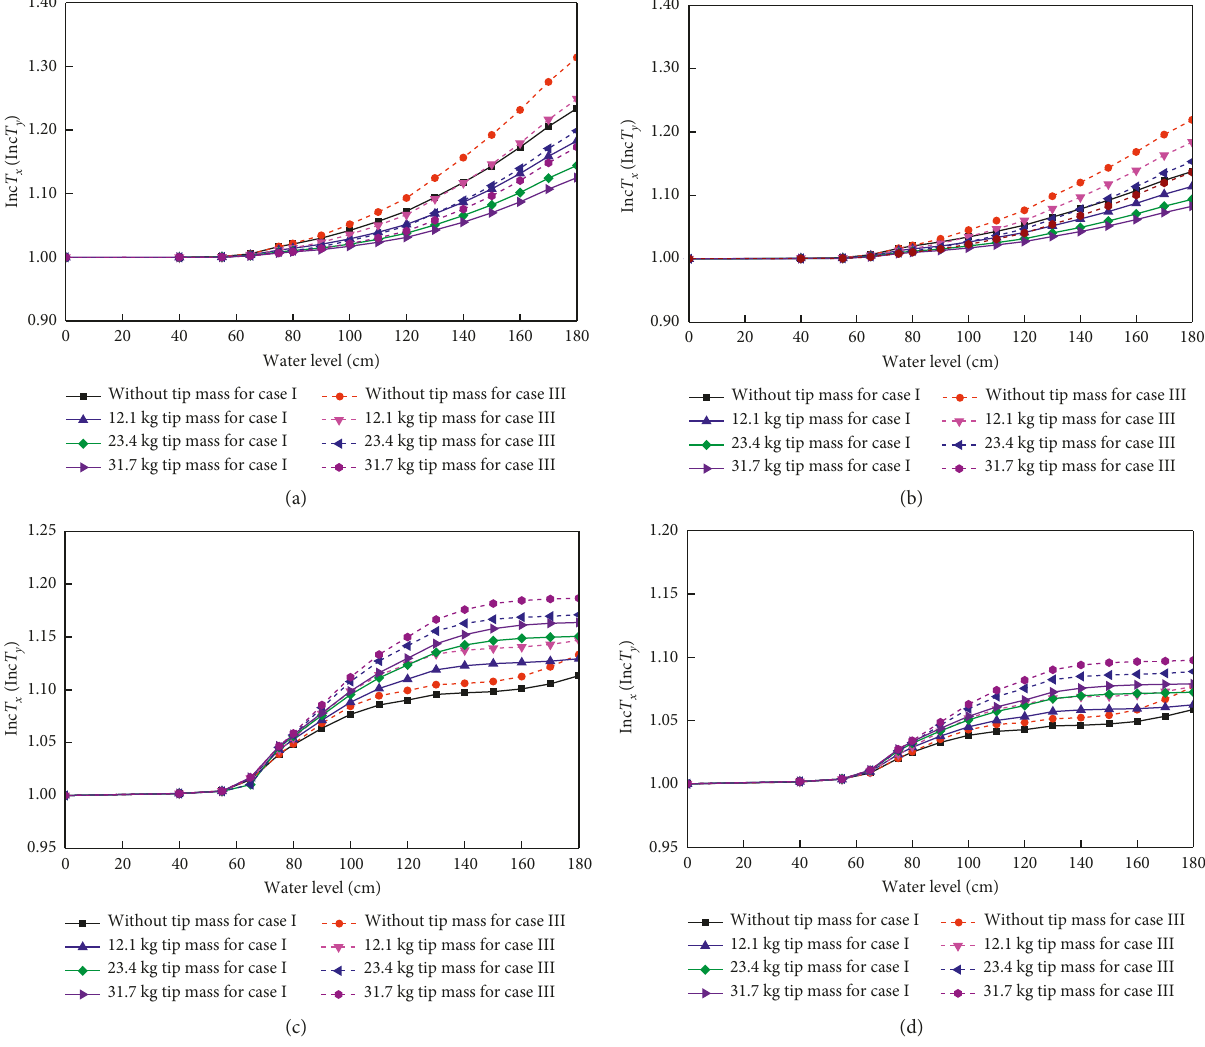
Figure 9: Computed period percentage increases for the pier specimen as a function of water level: (a) first mode along the x -axis; (b) first mode along the y -axis; (c) second mode along the x -axis; and (d) second mode along the y